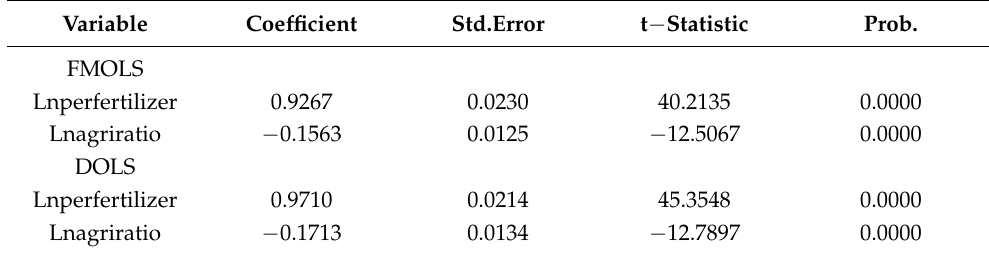
Table 7. The results of the robustness